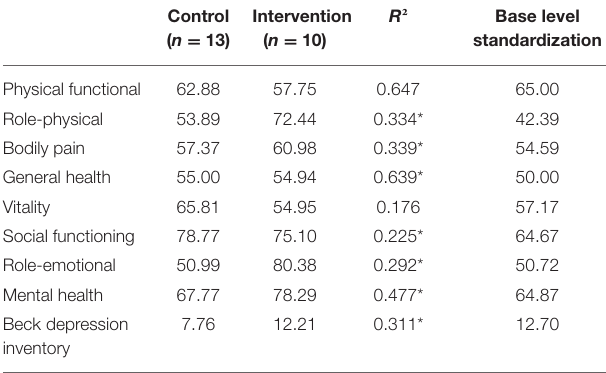
TABLE 3 | Adjustment measures for the ANCOVA models ( n = 23) when comparing the control group (no treatment) to the intervention group in the post-intervention in relation to the quality of life questionnaire SF-36 and the Beck Depression